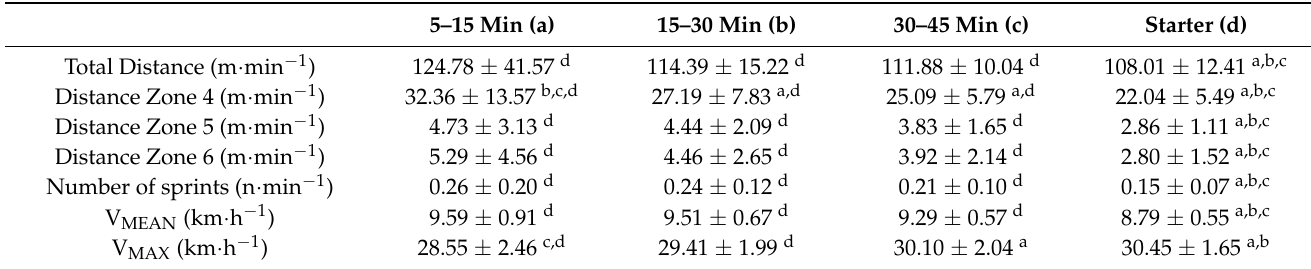
Table 1. Distances covered and high-intensity actions by substitutes who play 5–15 min (a),